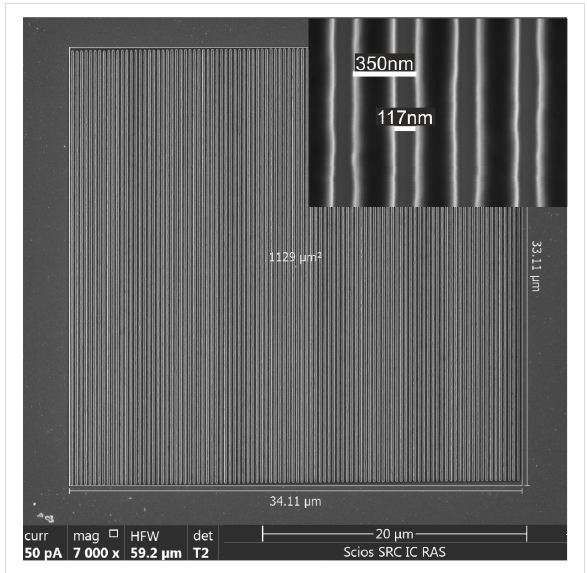
Figure 1: Electron microscope image of a grating with period p = 350 nm, duty factor w / p = 1/3.